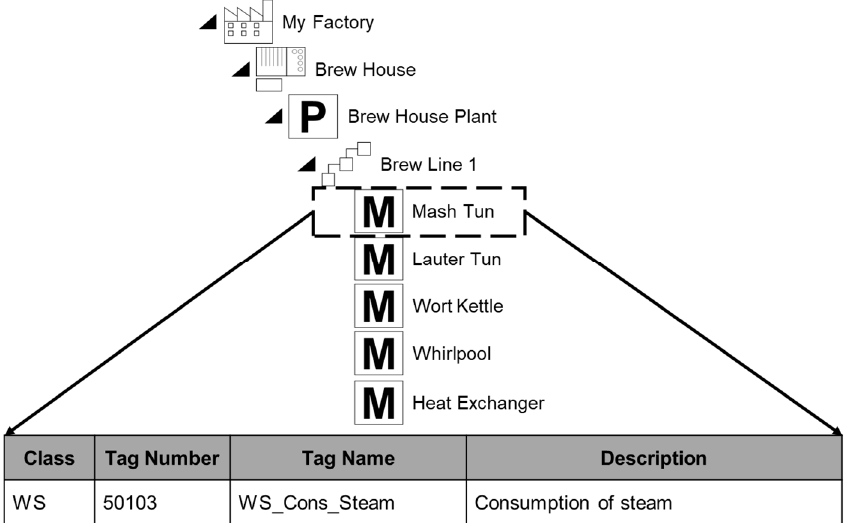
Figure 10. Plant model of the brewhouse.